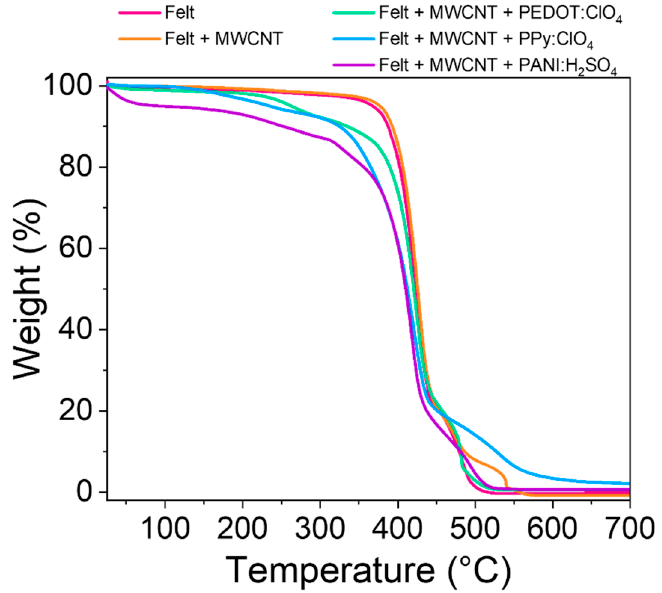
Figure 7. TGA curves of pristine felt fabric and the felt fabric coated with MWCNT, PEDOT:ClO 4 , PPy:ClO 4 , and PANI:H 2 SO 4 . Table 2. Weight loss temperature at different percentages and residue percentages at 700 ◦ C of pristine felt fabric and the felt fabric coated with MWCNT, PEDOT:ClO 4 , PPy:ClO 4 , PANI:H 2 SO 4